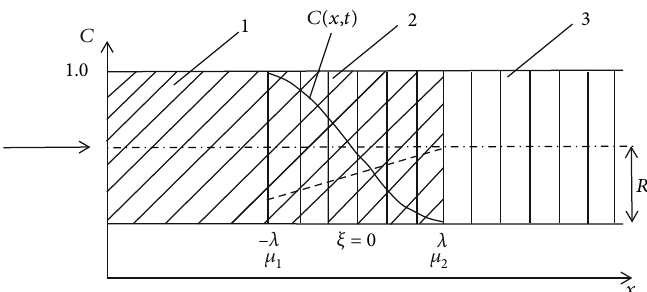
Figure 2: Schematic of CO